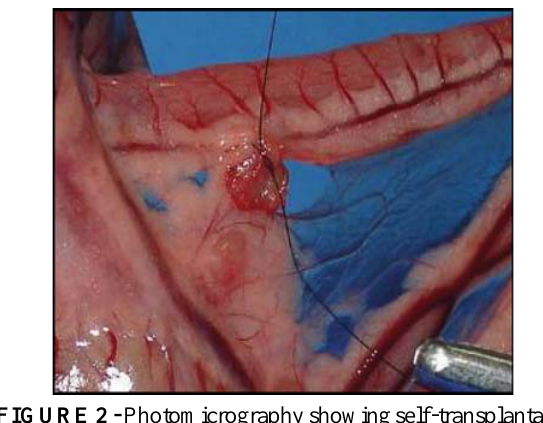
FIGURE 2 - Photomicrography showing self-transplantation in mesenterium attached with single stitch with 6-0 nylon, the endometrial surface of the endometriotic implant facing the lumen of the peritoneal cavity.